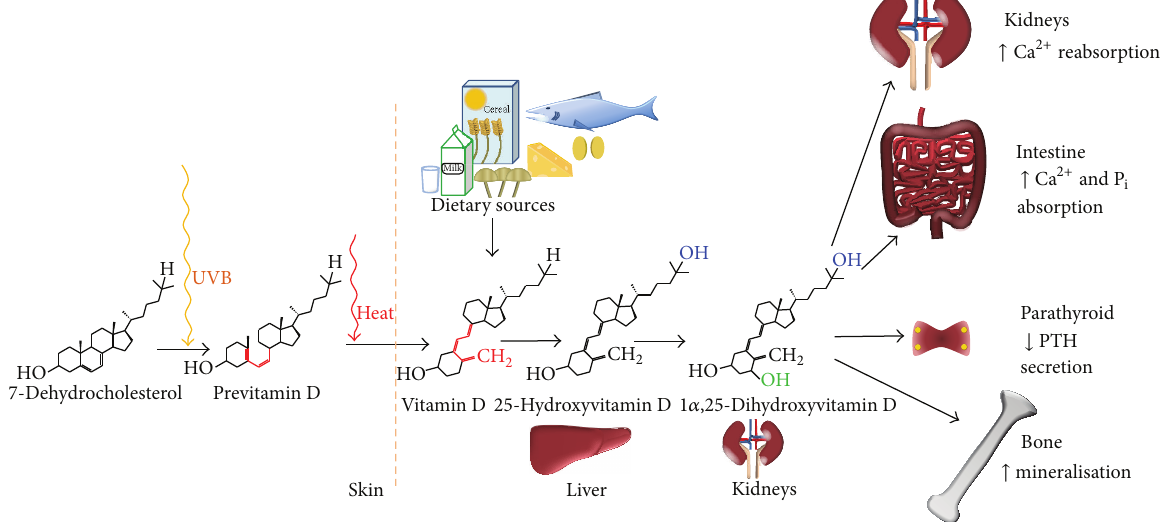
Figure 1: The biosynthesis of vitamin D and the major effects 1 𝛼 ,25(OH) 2 D 3 has on different organs. Synthesis begins in the skin before activation in the liver and kidneys. PTH: parathyroid hormone, Ca: calcium, and P i : inorganic